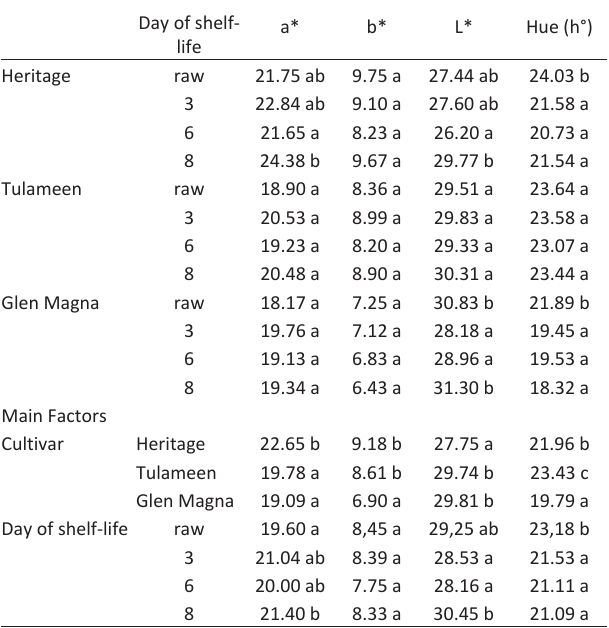
Different letters indicate significant differences among the days of shelf-life of the same cultivar or among the main factors (Tukey